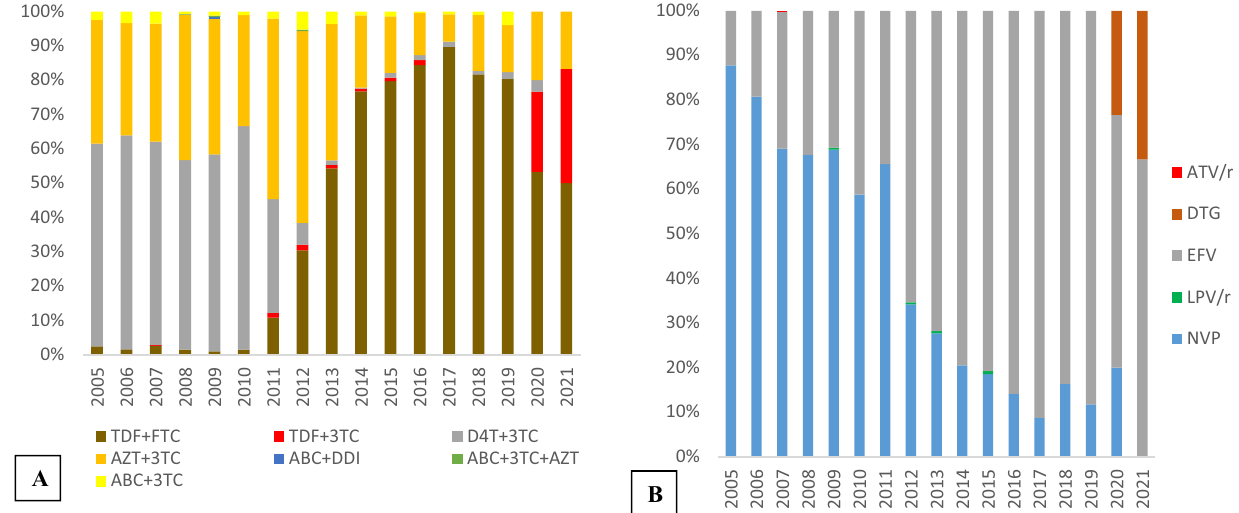
Figure 4. Distribution of cART regimens’ backbones and anchor drugs prescribed across study years among PLWHA in hospitals of Asmara, 2005–2021. Distribution of ( A ) backbone and ( B ) anchor drug classes prescribed in first cART regimens by year (2005 ‒ 2021). Anchor drugs: NNRTI Non-nucleoside reverse transcriptase inhibitor, PI Protease inhibitor (LPV/r: Lopinavir/ritonavir and ATV/r: Atazanavir/ritonavir), INSTI intergrase strand transfer inhibitor (DTG: Dolutegravir). Backbone drugs: ABC Abacavir, TDF Tenofovir disoproxil fumarate; 3TC: lamivudine, FTC: